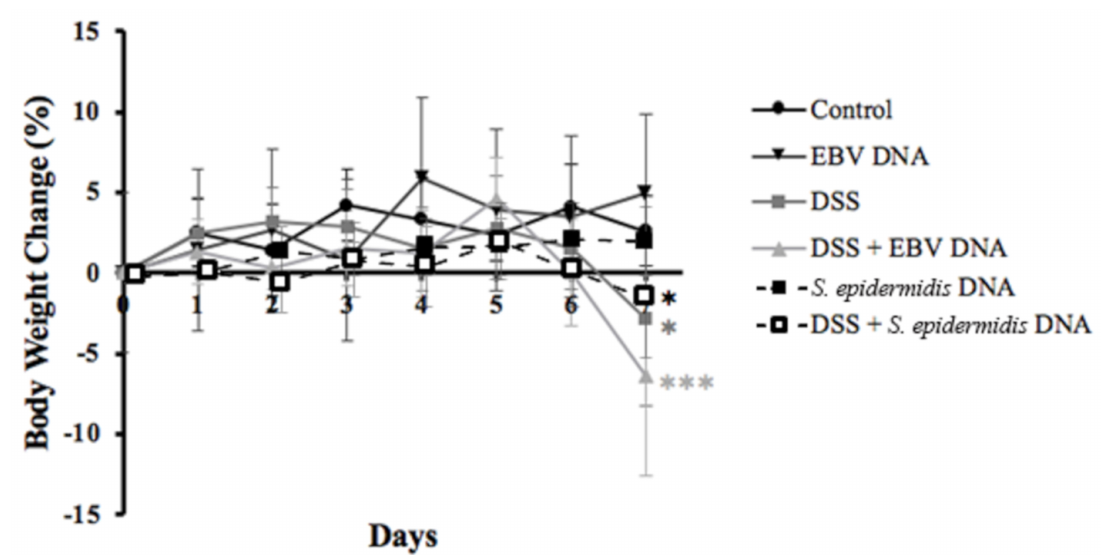
Figure 2. Average percent body weight change in control and experimental mouse groups used to assess the effect of Epstein–Barr virus (EBV) DNA on colitis severity in C57BL/6J mice. C57BL/6J mice ( n = 9–14 per group) received either 1.5% dextran sodium sulfate (DSS)-containing or regular drinking water for 7 days. Three DSS-treated groups were then rectally administered sterile water, Epstein–Barr virus DNA in sterile water or S. epidermidis DNA in sterile water on day 3. The other normal drinking water-fed groups were included as controls and also received sterile water, EBV DNA or S. epidermidis DNA by rectal gavage on day 3. Mouse body weight was evaluated daily, and the percent body weight change was calculated per mouse per group compared to its initial weight on day 0. Average weight per group per time point and standard deviations are indicated. * p < 0.05, *** p < 0.001, compared to the control group on the respective day of